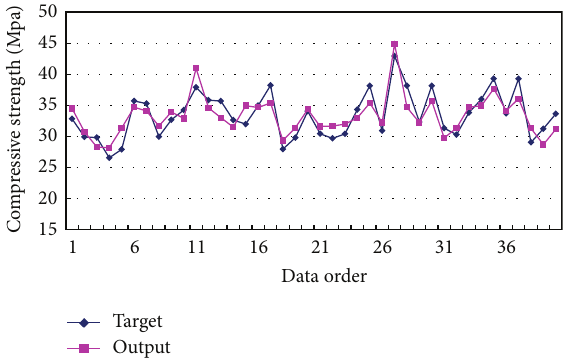
Figure 5: Results of testing the trained model (40 data sets).